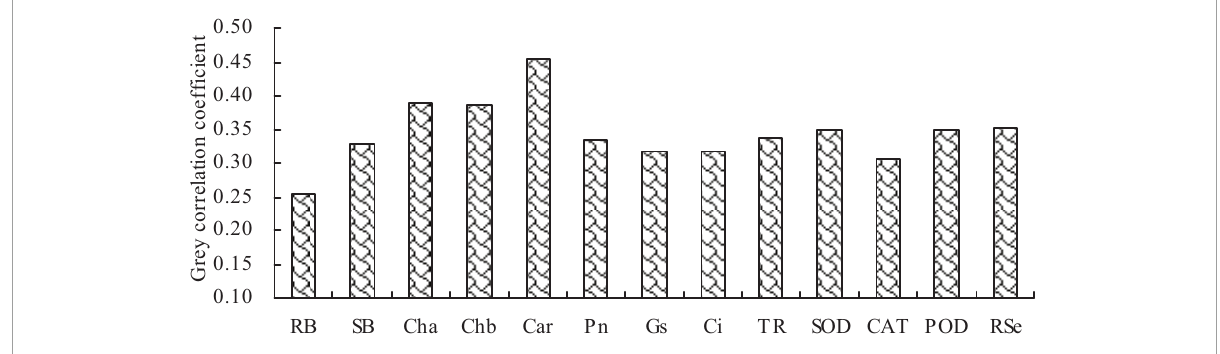
FIGURE5 Gray correlation coefficients of biomass, photosynthetic pigment content, photosynthetic characteristic parameter, antioxidant enzyme activity, and root Se content with shoot total Se content. RB, root biomass; SB, shoot biomass; Cha, chlorophyll a content; Chb, chlorophyll b content; Car, carotenoid content; Pn, net photosynthetic rate; Gs, stomatal conductance; Ci, intercellular CO 2 concentration; Tr, transpiration rate; SOD, SOD activity; POD, POD activity; CAT, CAT activity; RSe, root total Se